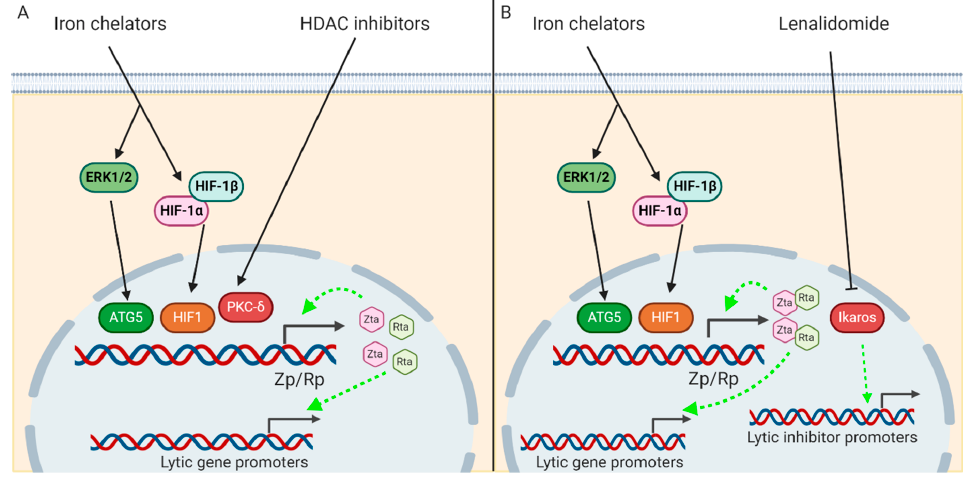
Figure 2. Combination of currently available lytic inducers. ( A ) Combination of iron chelators and HDAC inhibitors. Iron chelators and HDAC inhibitors reactivate EBV lytic cycle through autophagy-dependent and independent pathways, respectively. Their combination could potentially be synergistic in reactivating EBV lytic cycle. ( B ) Combination of iron chelators and lenalidomide. Combination of lytic inducers with different mechanisms for EBV lytic reactivation may have synergistic effects in reactivating the EBV lytic cycle. Lenalidomide reactivates EBV lytic cycle by suppressing Ikaros, which inhibits the expression of transcription factors that inhibit EBV lytic cycle. Manipulation of Zta expression by iron chelators, together with the suppression of inhibitory factors that prevent Zta transactivation of other lytic genes by lenalidomide, may provide a feed-forward loop for lytic reactivation, thus enhancing EBV lytic induction.